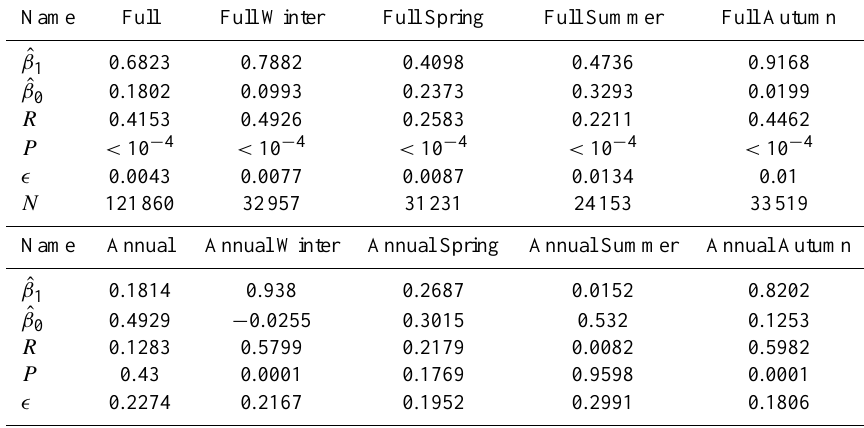
Table 4. Linear regression output parameters for